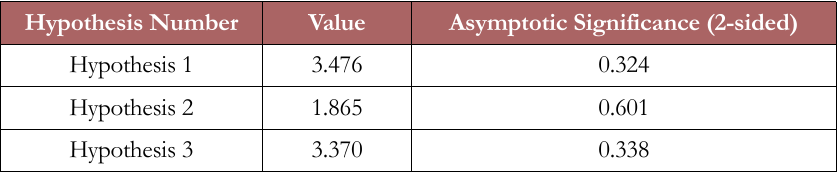
Table 9. Chi-square test